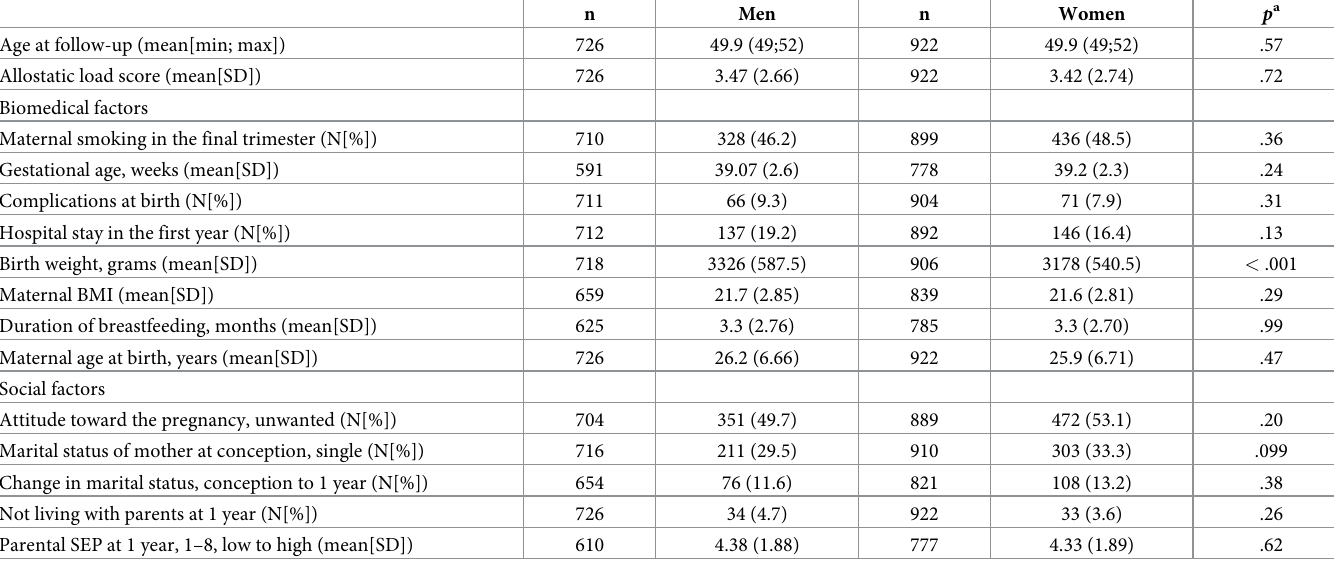
Table 1. Sex-stratified descriptive statistics of early life biomedical and social factors including test for sex